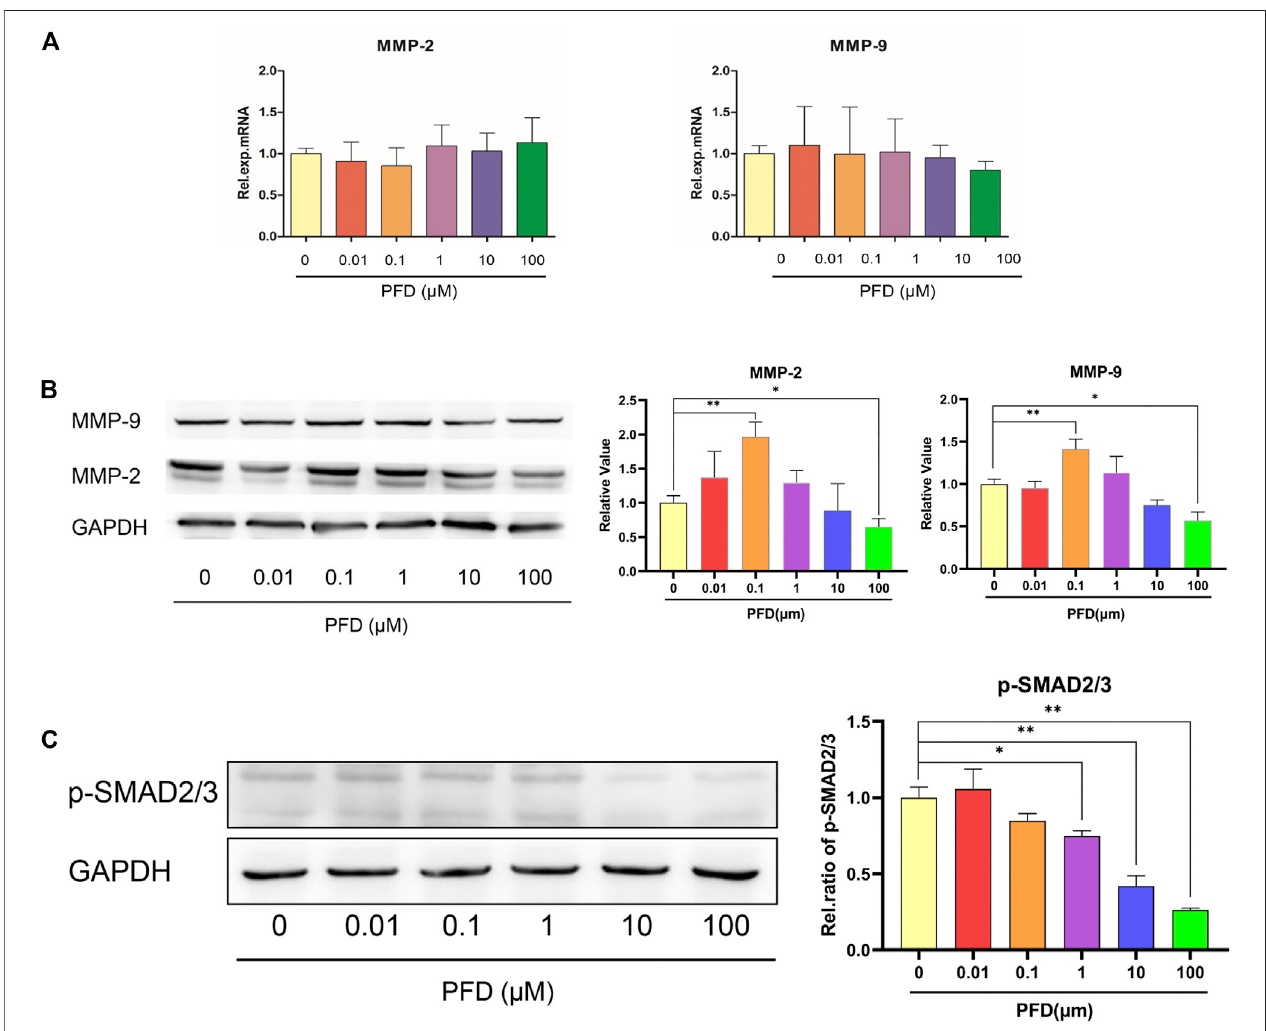
FIGURE 2 | The bidirectional effect of PFD on MMPs is independent of the TGF/SMAD signaling pathway. The EA.hy926 cells were pre-treated with different concentrationsofPFDfor6/24h,andassessedbyreal-timeqPCRandwesternblotanalysis: (A) RelativemRNAexpressionofMMP-2andMMP-9; (B) MMP-2andMMP-9 protein expression; (C) p-SMAD2/3 protein expression. * p < 0.05; ** p <